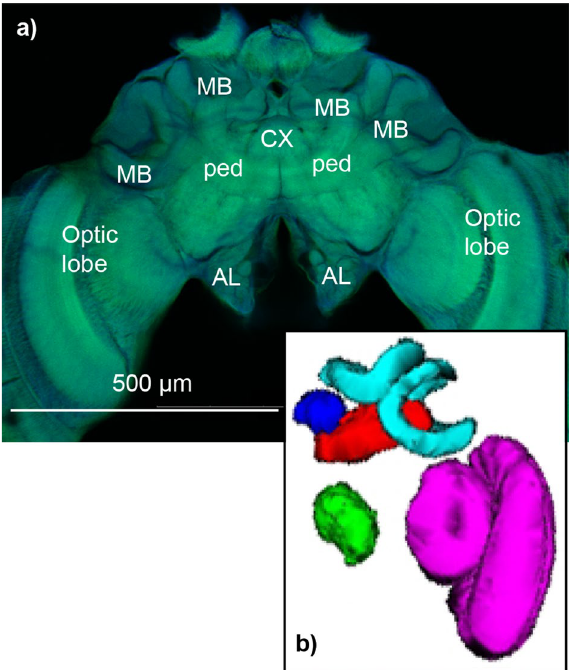
Figure 1. ( a ) Confocal micrograph showing mushroom body calyces (MB) and peduncle (ped), the central complex (CX), antennal lobes (AL), and optic lobes; scale bar = 500 μm. ( b ) Reconstructed volume of a representative brain, with AL in green, CX in royal blue, MB peduncle in red, MB calyces in light blue, and OL in